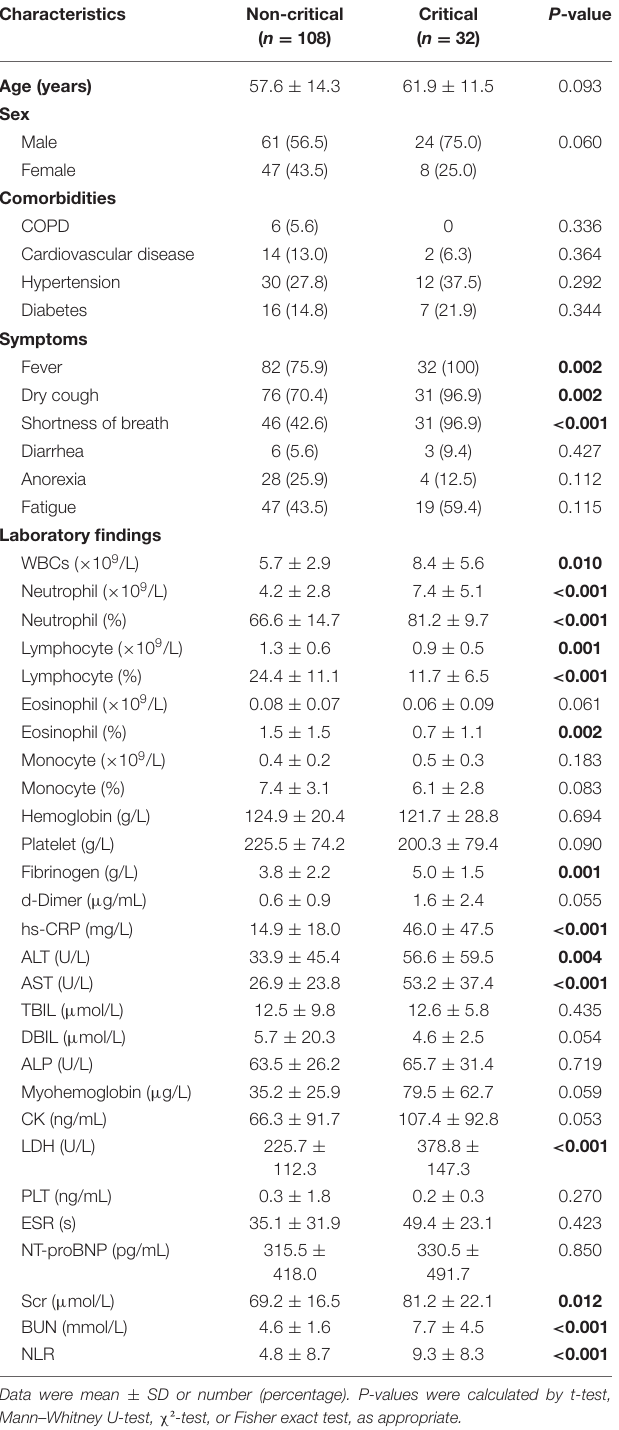
TABLE 3 | Comparison of quantitative CT features between non-critical and critically ill groups. CT